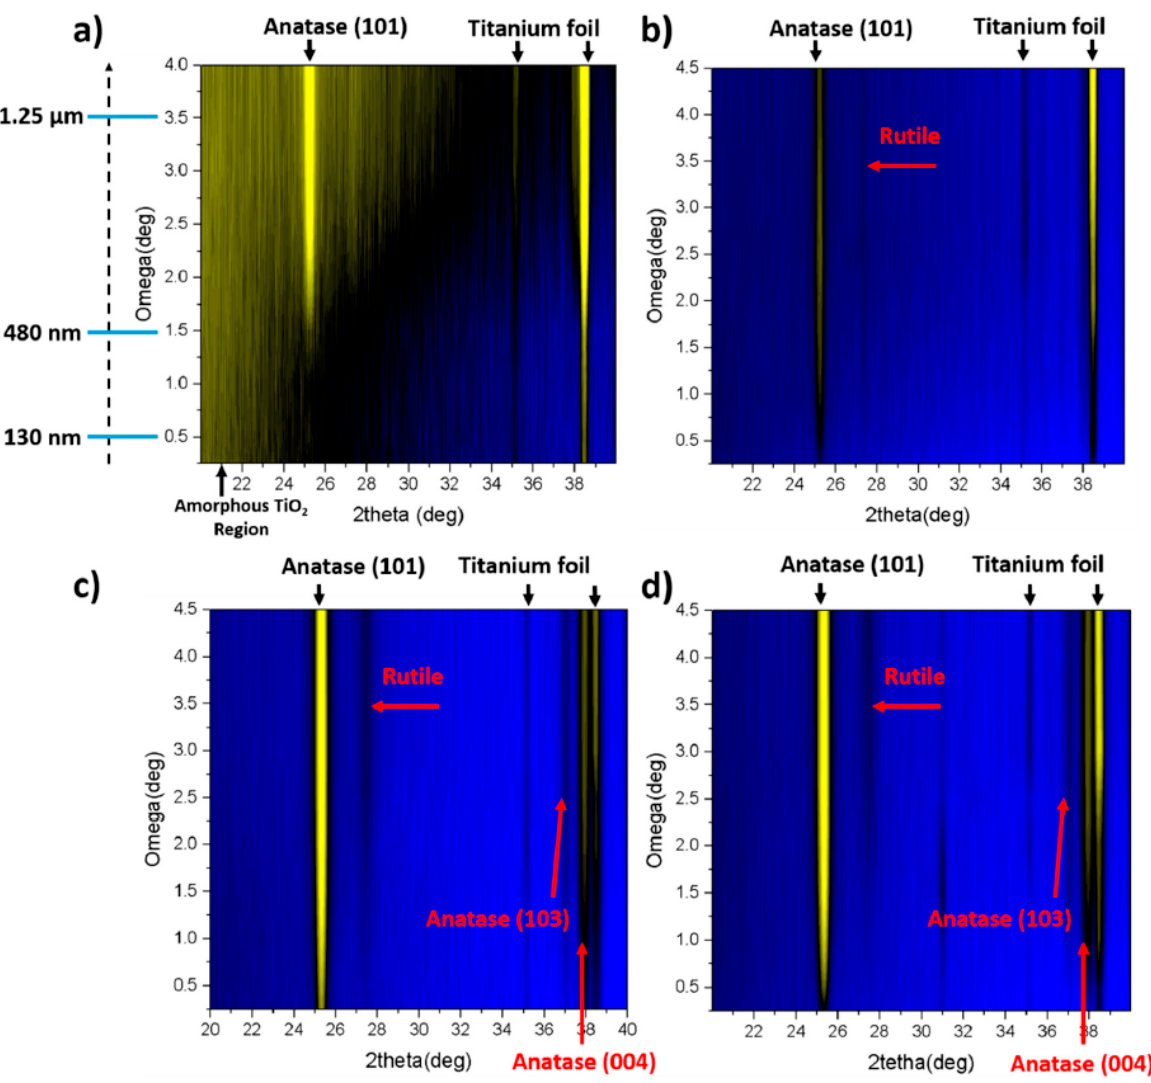
Figure 8. Gi-XRD-2D image scans of amorphous ( a , b ) and calcined ( c , d ) TiO 2 nanotubes annealed by laser in air ( a , c ) and vacuum ( b , d ). Reprinted with permission from [56].